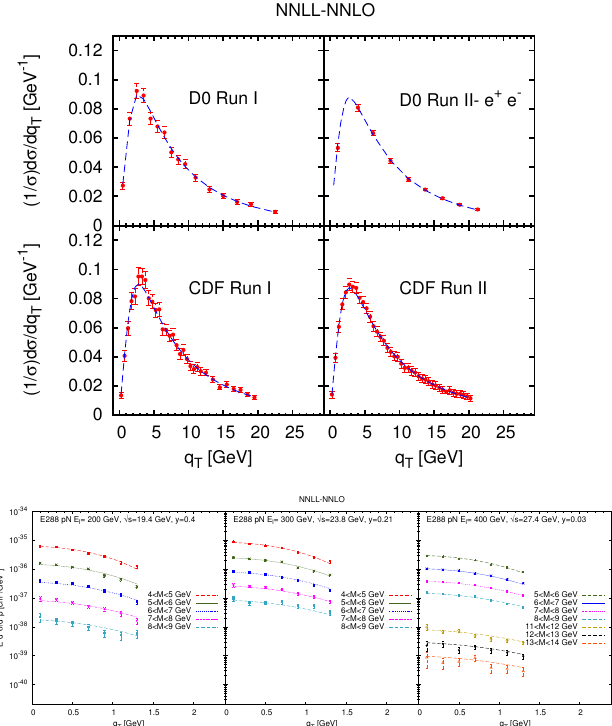
Figure 1. Best-fit curves for the analysis with D NP (cid:2) 0 (Eq. (9)), at NNLL accuracy using the MSTW08 [26] set for the PDFs. Comparison with Tevatron data (upper-left panel), with R209 data (upper-right panel) and E288 data (lower panels).